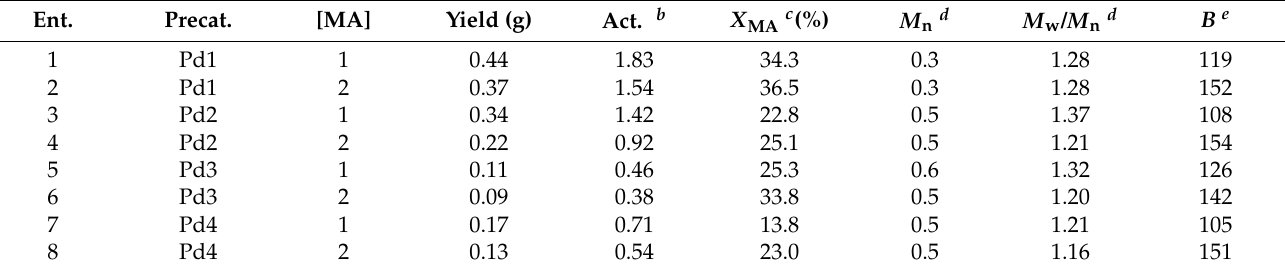
Table 2. Propylene-MA copolymerization. a .